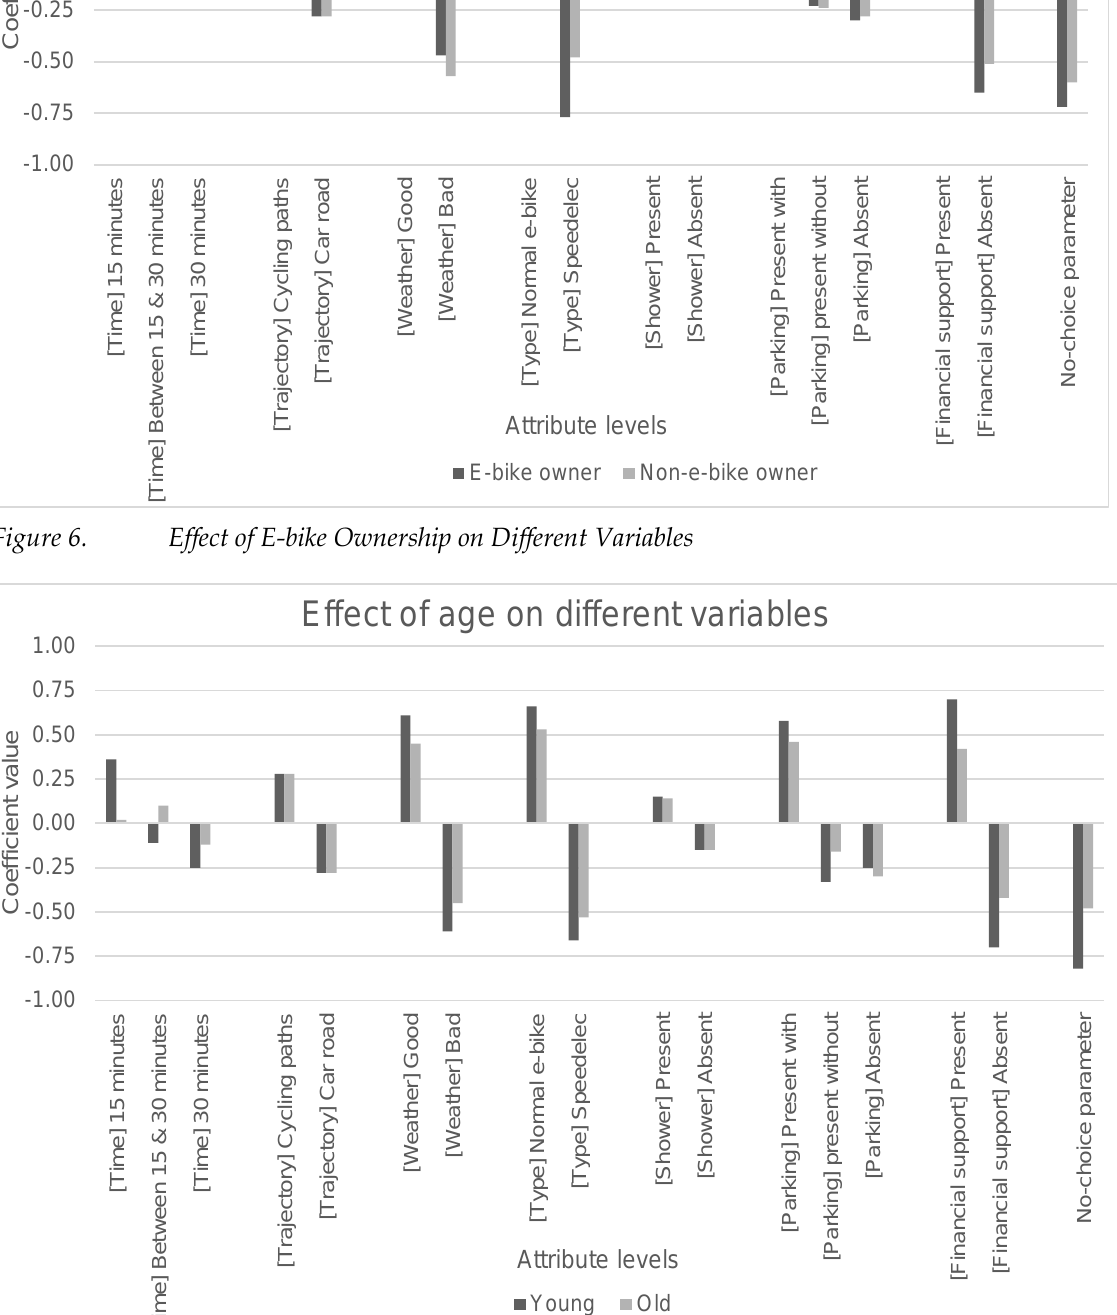
Figure 7. Effect of Age on Different Variables